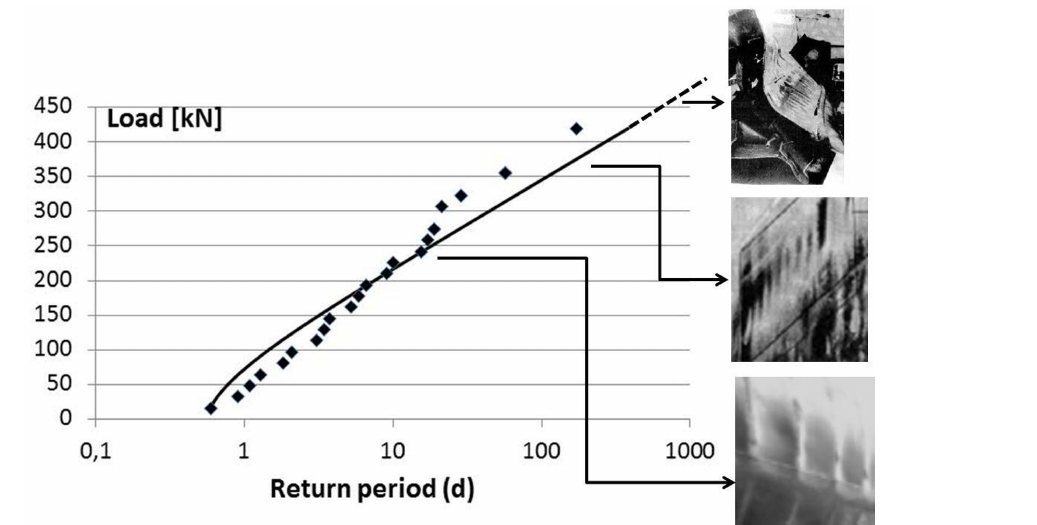
Figure 13. Measured load on one frame at the bow of MS Kemira obtained during the 1985–1991 period (Kujala, 2017), also showing the possible effect of the increasing load on damage to the ship shell